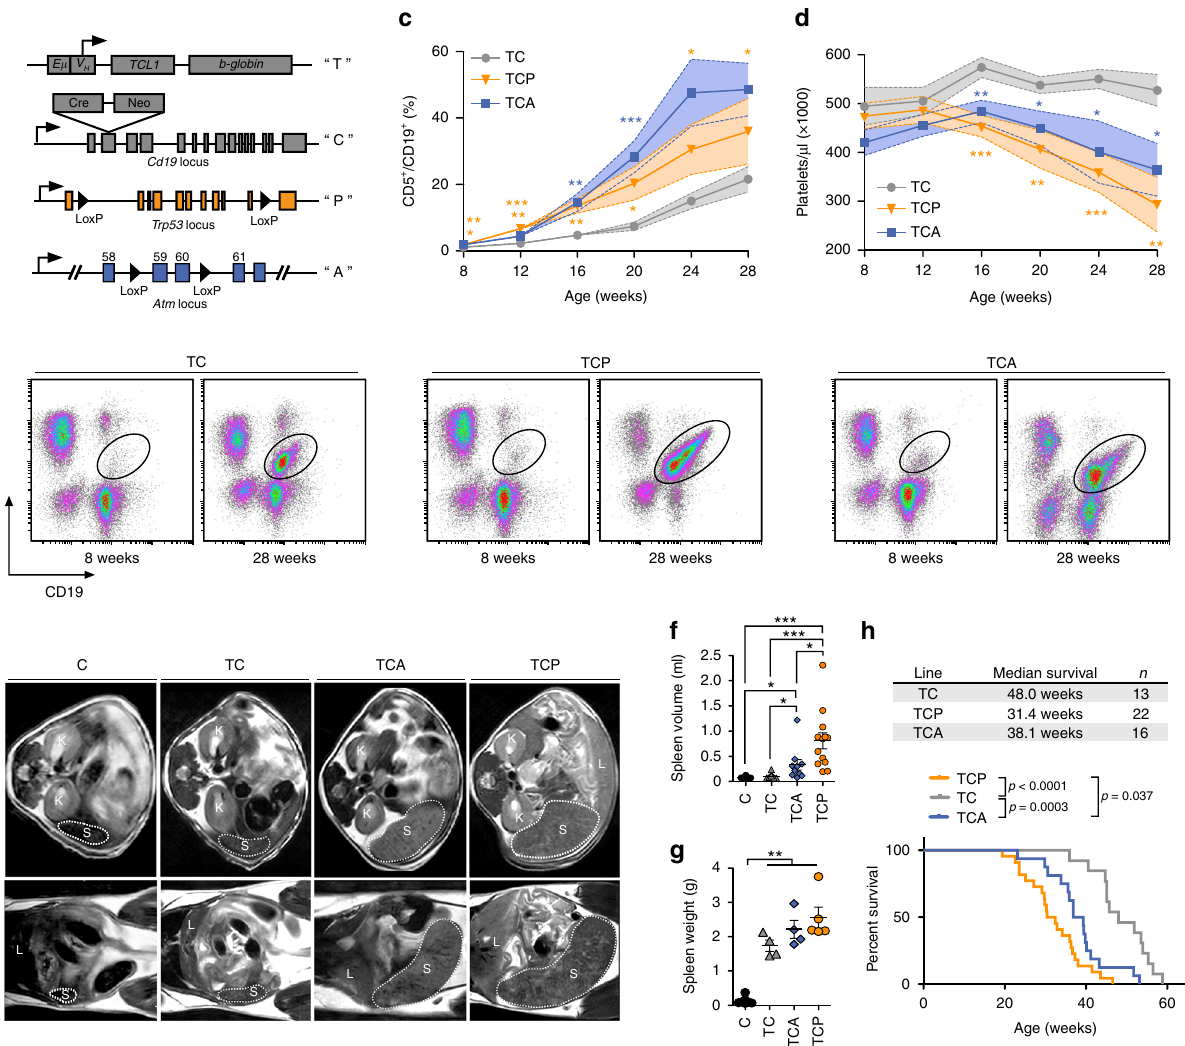
Fig. 1 Enhanced disease progression in TCP and TCA mice. Conditional B cell-speci fi c deletion of Trp53 and Atm in TCL1 -driven murine CLL leads to earlier disease onset and reduced overall survival. a Schematic illustrations of the alleles used in this study. b Representative CD5/CD19 plots from fl ow cytometric analysis of the peripheral blood of 8- and 28-week-old TC, TCP, and TCA animals. The percentage of CD5 + /CD19 + cells c and platelet counts d in the peripheral blood of TC, TCP, and TCA mice ( n = 20 for each genotype) were measured every 4 weeks, starting at 8 weeks of age. e Representative MR images of C, TC, TCP, and TCA mice at 30 – 32 weeks of age ( S spleen, L liver, K kidney). Quanti fi cation of spleen volumes from MR images (C: n = 11, TC: n = 13, TCA: n = 10, TCP: n = 13) at 30 – 32 weeks of age are illustrated in f and spleen weights at necropsy ( n ≥ 4/line) is illustrated in g . For wild-type controls, 15 animals sacri fi ced between 30 and 70 weeks of age were used, as a moribound state does not exist for this genotype. h Overall survival curves for TC, TCP, and TCA animals in Kaplan-Meier format. Envelopes and error bars represent SEM. c , d , f , g Welch ’ s t -test, h log-rank test. * p ≤ 0.05; ** p ≤